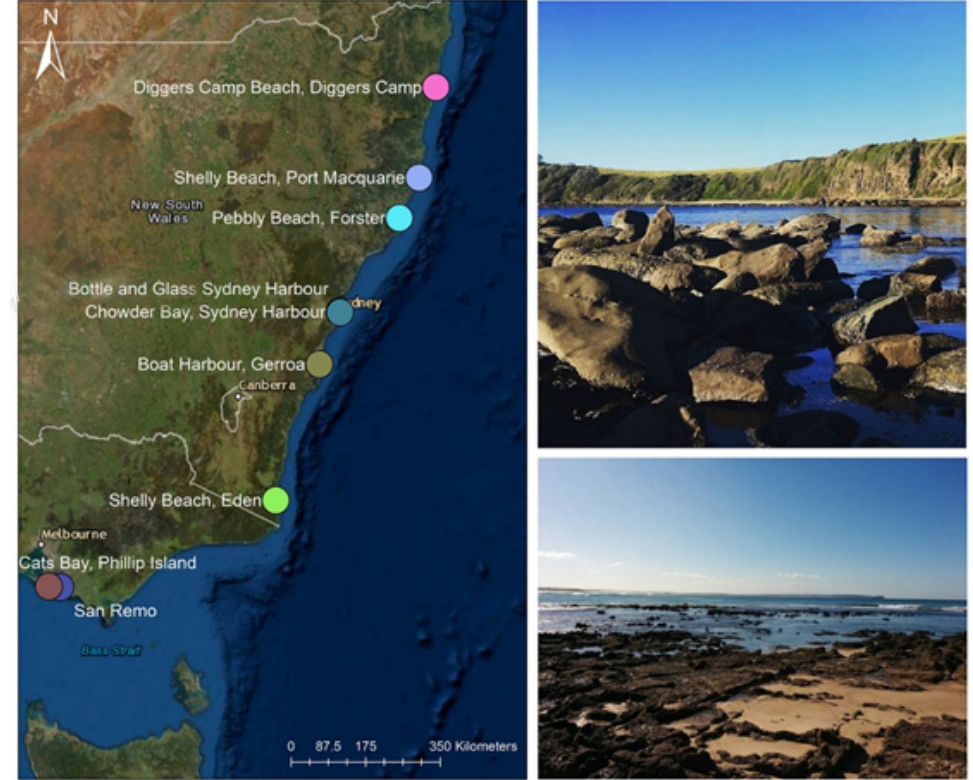
Figure 1. Locations surveyed during this study ( left ) and examples of boulder beaches: Boat Har- bour, Gerroa, NSW ( top right ), Inverloch, VIC ( bottom right ). Photos: ESRI ArcGIS ( left ), Jorge Rodríguez ( right ). Table 1. Overview of sampled rock size categories from boulder beaches in southeastern